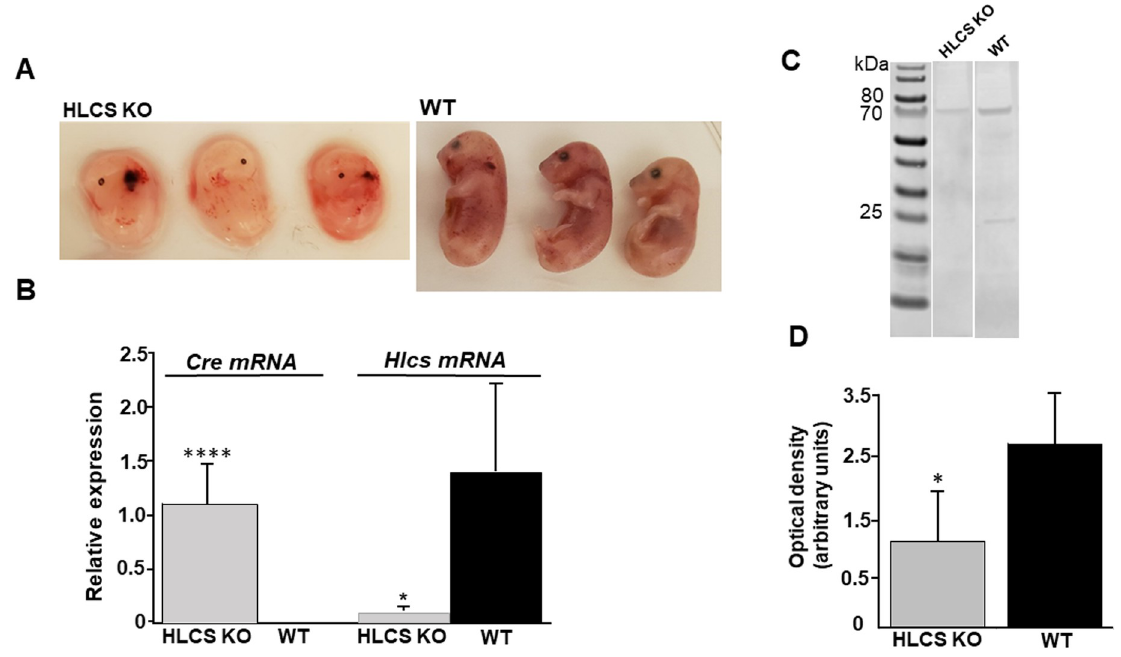
Fig 6. Embryonic development in Hlcs tm1 . 1Jze mice. (A) Embryos were dissected from Hlcs tm1 . 1Jze and WT dams 2 days after the final tamoxifen injection on embryonic day 14.5. (B) Expression of Cre mRNA and Hlcs E8 mRNA in Hlcs tm1 . 1Jze embryos. (C and D) Expression of Hlsc at protein level in Hlcstm1.1Jze embryos. � P < 0.05 vs . WT; ���� P < 0.0001 vs . WT; n = 3. Values are means ± standard error of the mean.